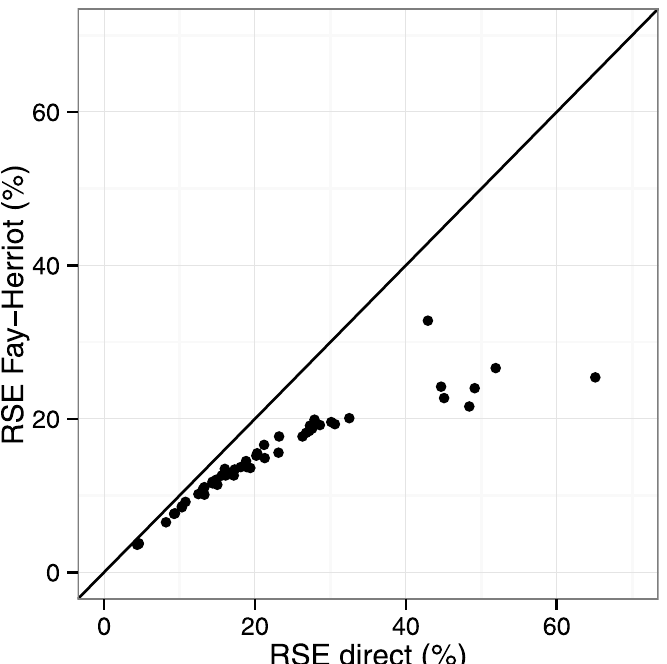
Fig 1. Relative standard errors of district-level estimates. Relative standard errors (RSE) of the 52 South African district-level HIV prevalence estimates obtained from the AIC-best Fay-Herriot area-level model and direct (survey domain)